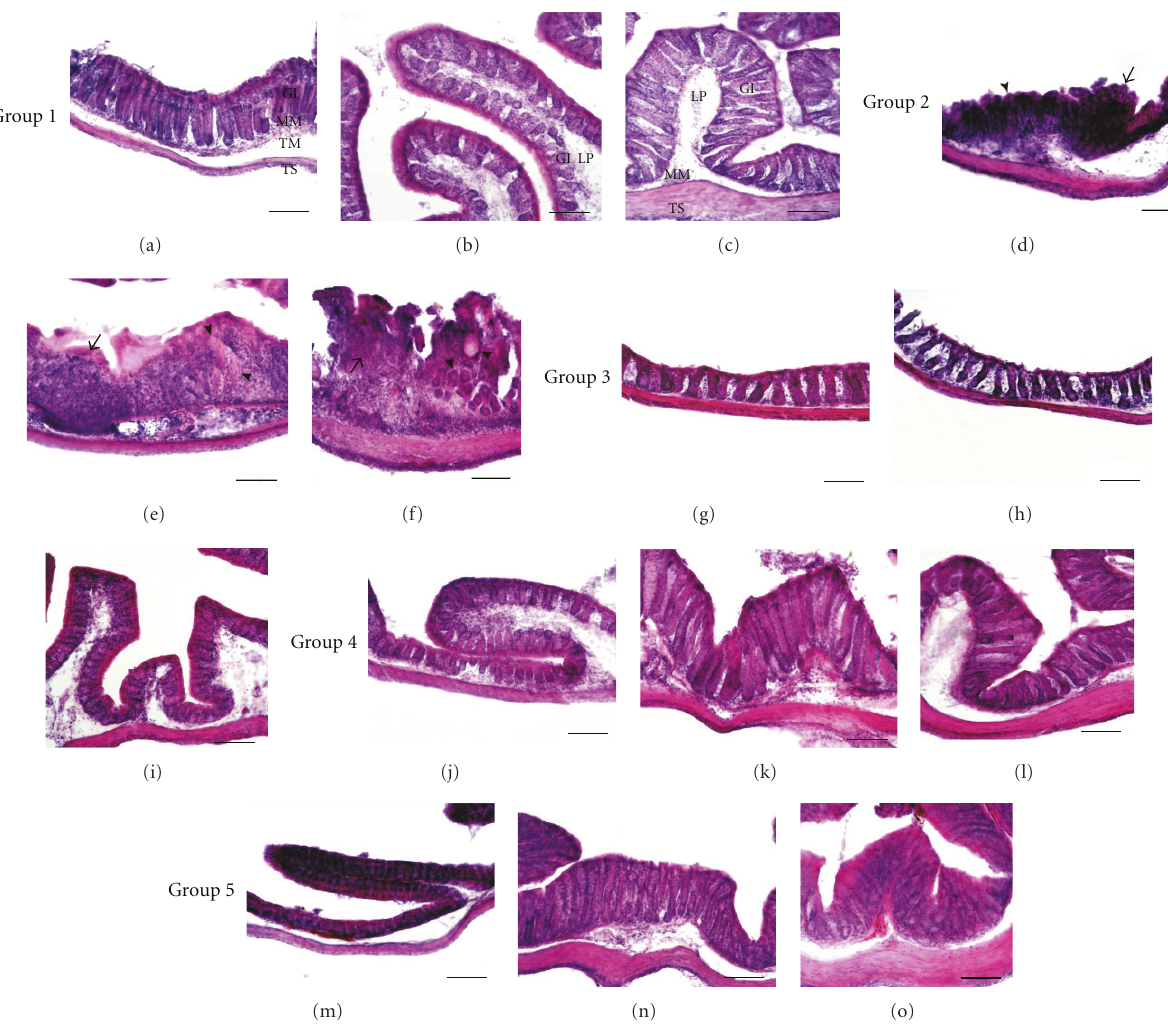
Figure 2: Histological sections of three di ff erent portions of the experimental mice colon to show histopathological lesions identified by hematoxylin and eosin staining. (a – c) Transverse sections at three di ff erent colorectal levels (proximal, middle, and distal) of mice group 1 treated with FR91 (10%). Note the absence of colonic lesions and the similar epithelial structures observed in normal control mice. (d – f) Transverse sections at three di ff erent colorectal levels of mice group 2 treated with DSS (2%) for 5 weeks. In each studied level, multiple histopathological lesions were observed, being particularly clear the severe-grade dysplasia (arrowheads in (d) and (e)) developed in the colon of mice from this group, together with aberrant crypts (arrow in (d)), adenomatous polyps (arrowhead in (f)), and incipient ulcerations (arrow in (f)). (g – I) Transverse sections at three di ff erent colorectal levels of mice group 3, with the administration of DSS (2%) for 5 weeks and treated with FR-91 (5%). Although these three colonic levels show a low-grade dysplasia and some scattered mucosal ulcerations, the structural histological pattern in general is functional. (j – l) Transverse sections at three di ff erent colorectal levels of mice group 4, with the administration of DSS (2%) for 5 weeks and treated with FR-91 (10%). This group showed a better colorectal histological organization than that observed in group 3 although there are some mild-grade dysplastic crypts mainly at the distal segments. (m – o) Transverse sections at three di ff erent colorectal levels of mice group 5, with the administration of DSS (2%) for 5 weeks and treated with FR-91 (20%). These sections show a normal epithelial organization, with well-di ff erentiated cryptal cells and no atypical lesion features. Scale bar: 100 μ